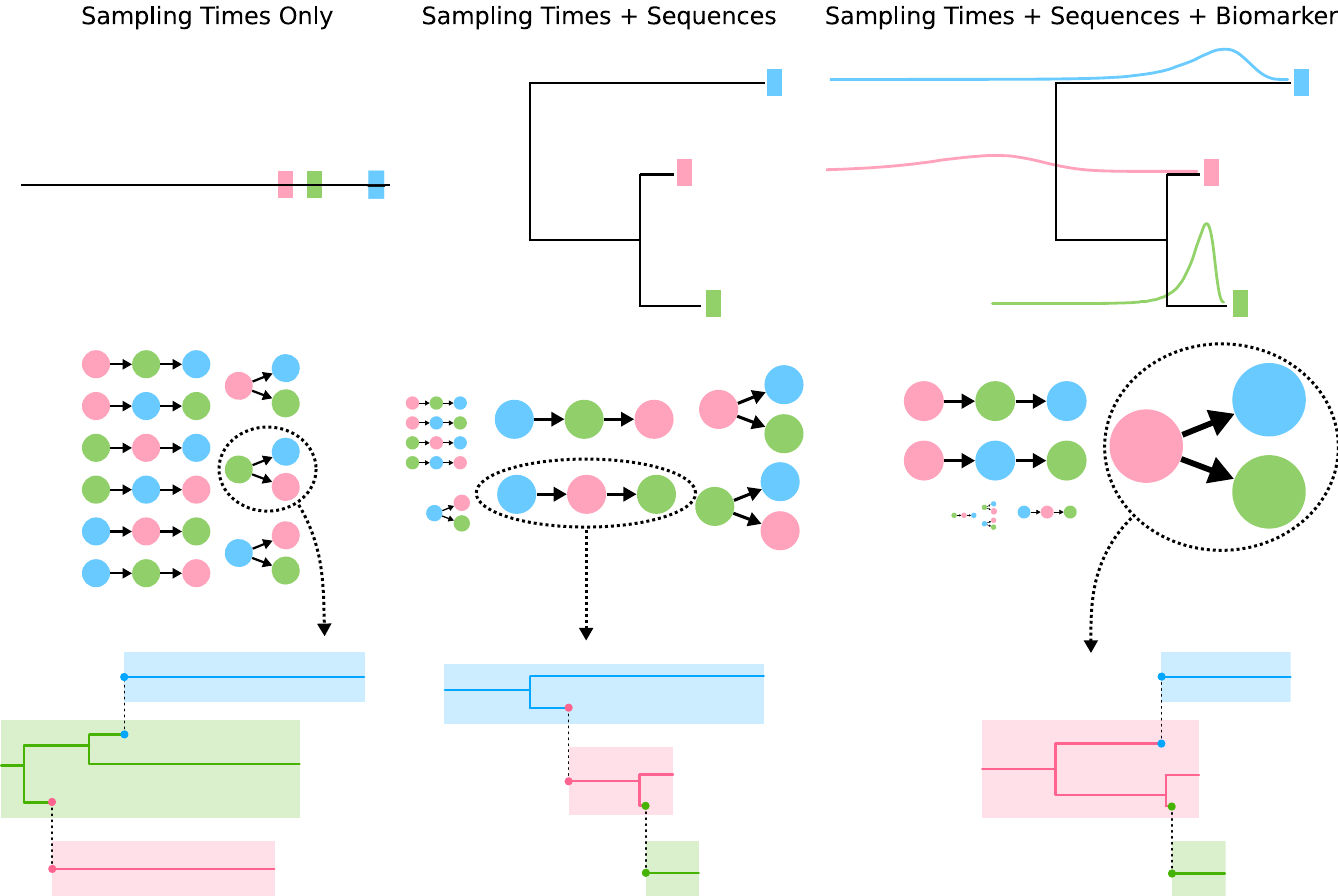
Fig 1. Conceptual Model Motivation. The level of information available for inference (top row) affects the support for the possible transmissions between hosts (filled colored circles in middle row and colored boxes in bottom row). The information from the biomarkers is shown as probability densities of the time of infection for each host. The middle row shows examples of plausible transmission histories (excluding infection times), with the arrows indicating the direction of transmission (pointing from infector to recipient). The relative size of each possibility corresponds to the order of magnitude of the posterior probability for that configuration, with larger configurations having greater support. For each level of information, a transmission history with a phylogeny is shown from a selected configuration, with transmissions indicated by dashed vertical lines (bottom row). The left side of each colored box in the transmission history represents the time of infection, and the right side the time of sampling. Note that the phylogeny is identical in the middle and right panels of the bottom row, but the inferred transmission history is